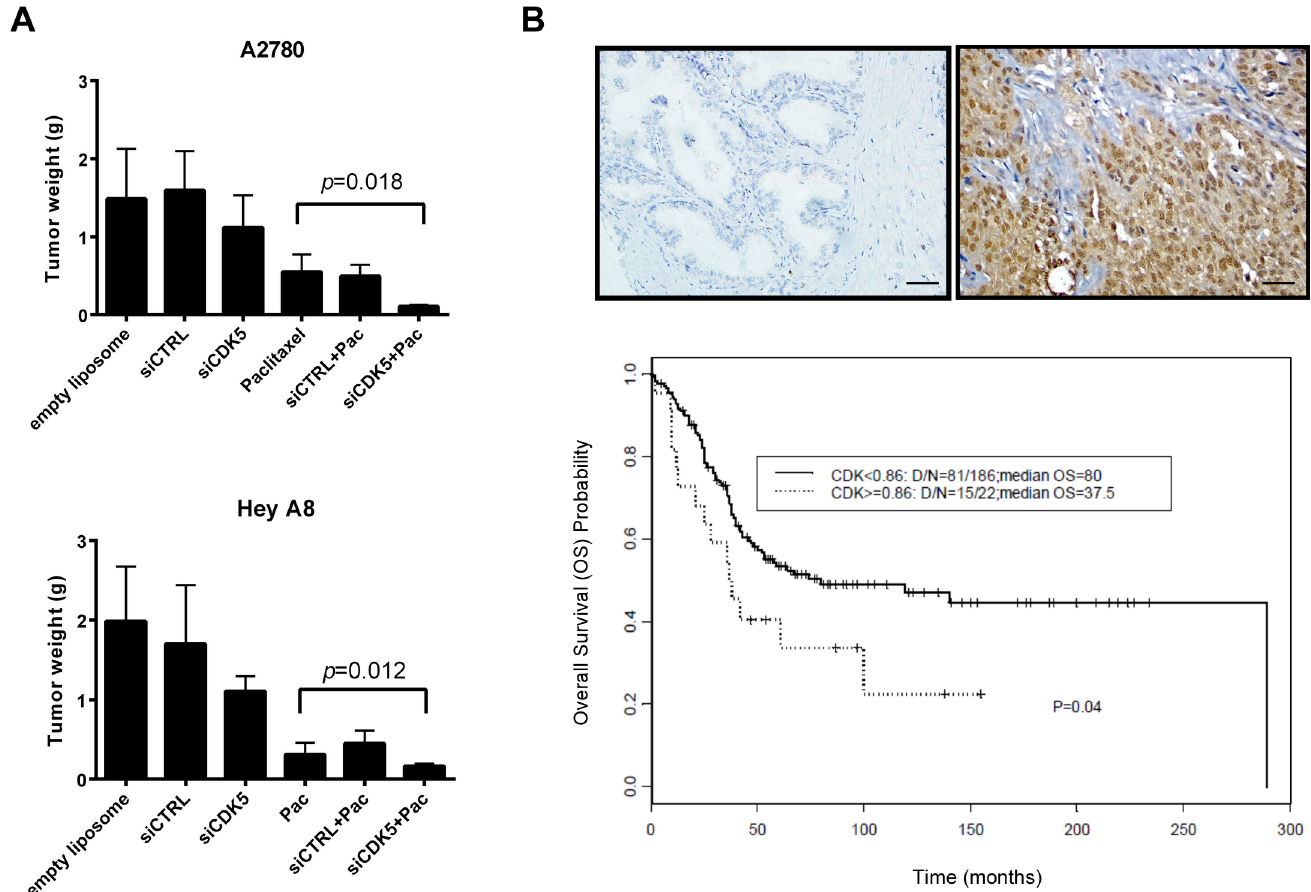
Fig 6. CDK5 siRNA enhances the response to paclitaxel in HEY and A270 human ovarian cancer xenografts and CDK5 expression correlates inversely with ovarian cancer patient survival. ( A ) CDK5 siRNA-DOPC inhibited ovarian cancer xenograft growth and enhanced paclitaxel therapy in nu/ nu mice. Groups of 10 mice were injected with HEY A8 or A2780 cancer cells and treated as described in Materials and Methods. Xenograft growth was measured by tumor weight on day 28 after tumor cell injection. ( B ) CDK5 expression correlated with patient survival. TMA Sections (215 patient samples) from department of Pathology were stained with specific antibody against CDK5. Repetitive CDK5 negative and positive images are shown in here. The relation between CDK5 expression level and prognosis was evaluated by Kaplan-Meier survival analysis.